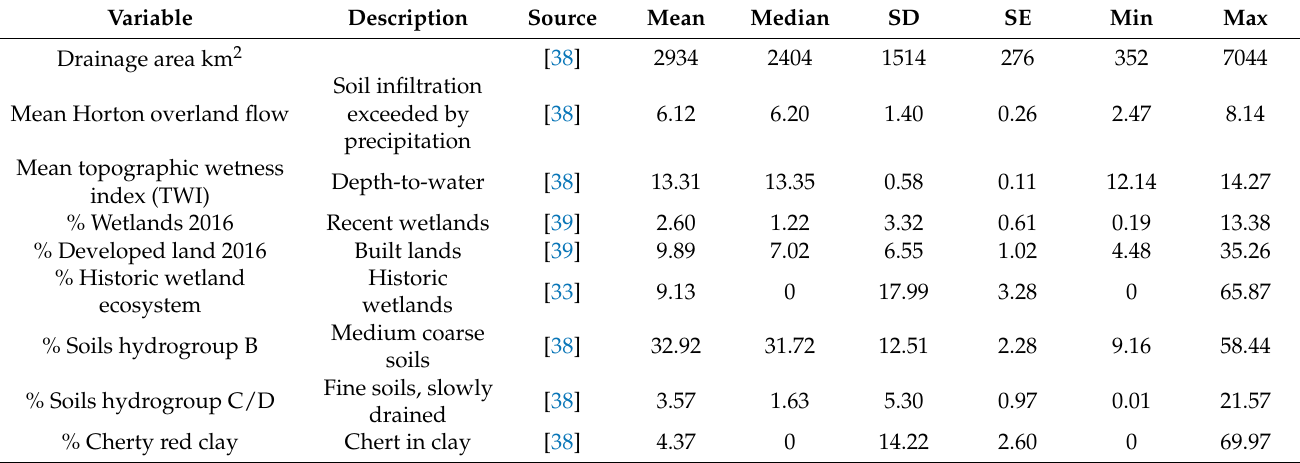
Table 3. Description, source, and statistics of nine variables included in the model.